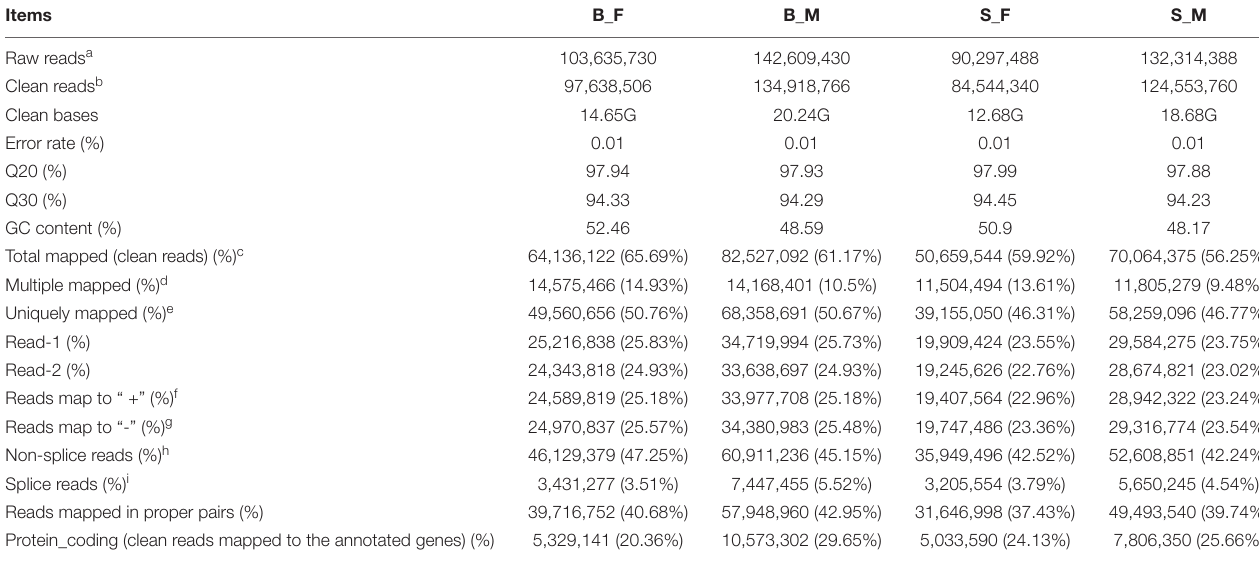
TABLE 1 | Statistics of the RNA-seq for each sample.